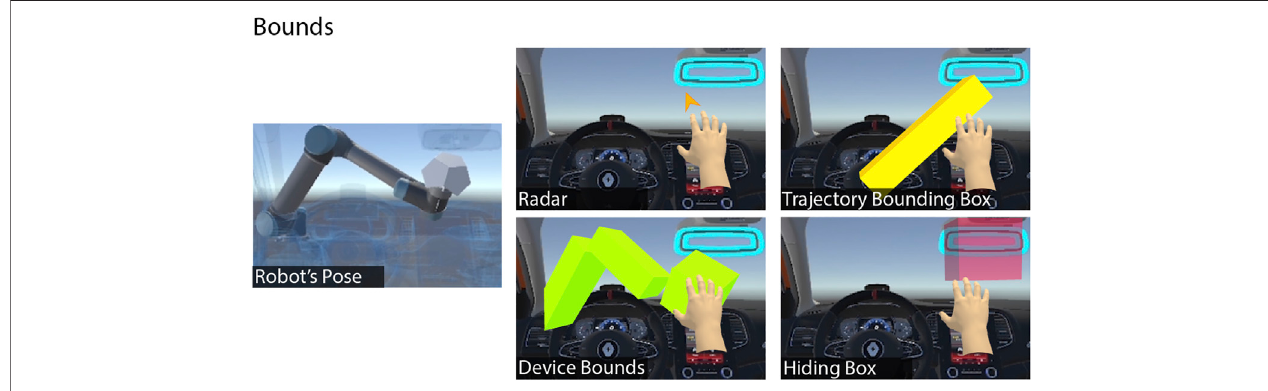
FIGURE 6 | The bounds group. This group comprises techniques that bound the ETHD device for protecting the user from getting closer to the ETHD.